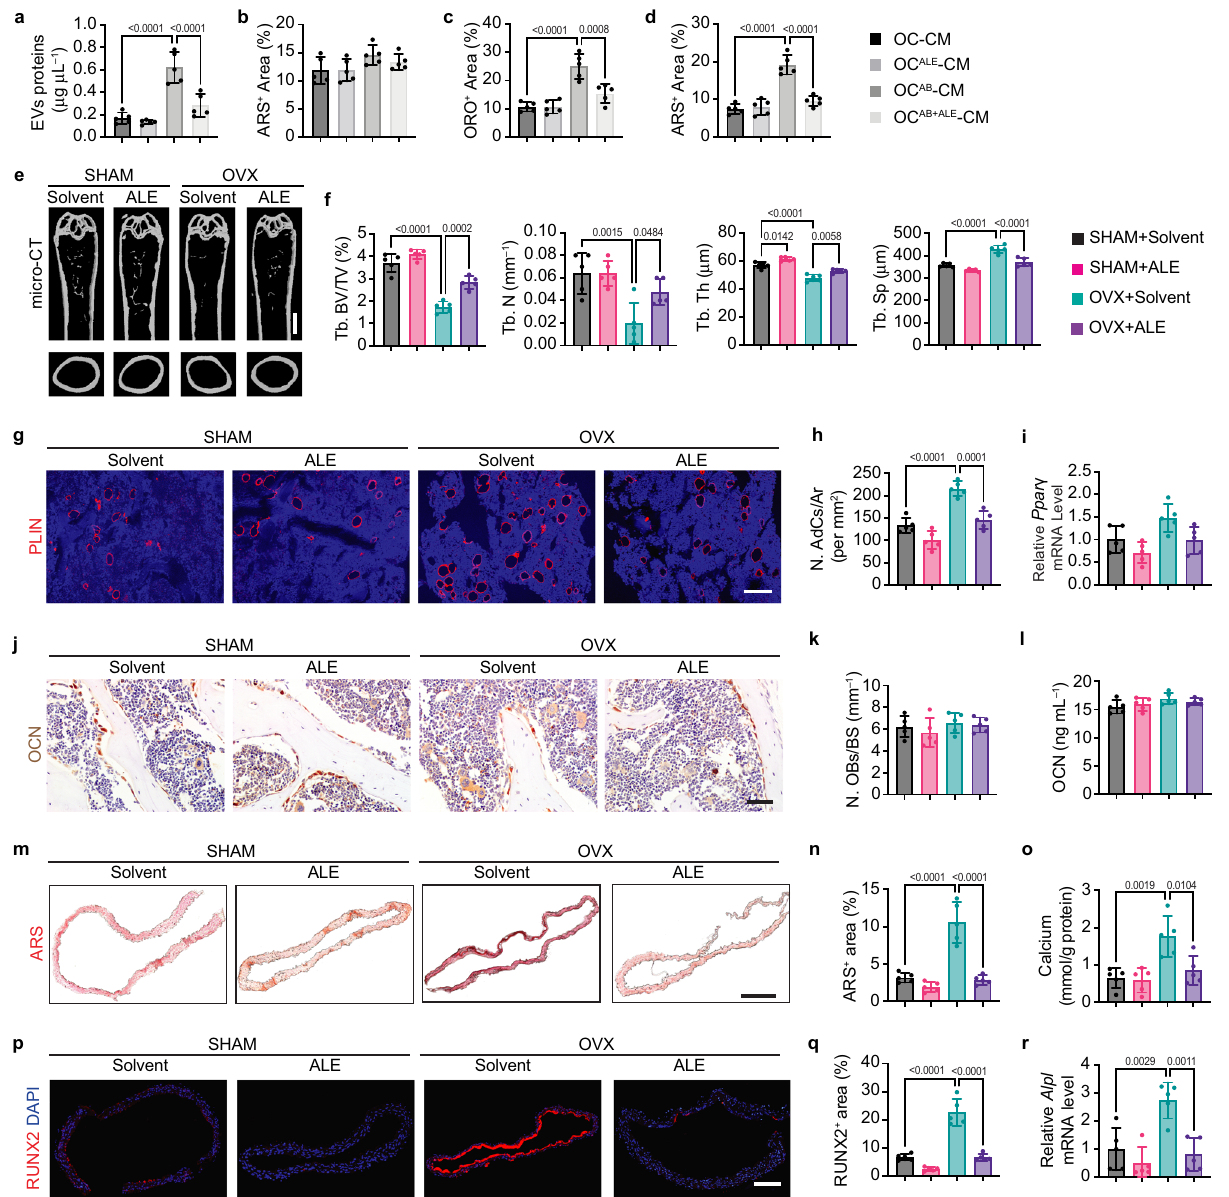
Fig. 5 ALE down-regulates AB-EVs release and attenuates bone-fat imbalance and VD3-induced vascular calci fi cation in aged OVX mice. a Total